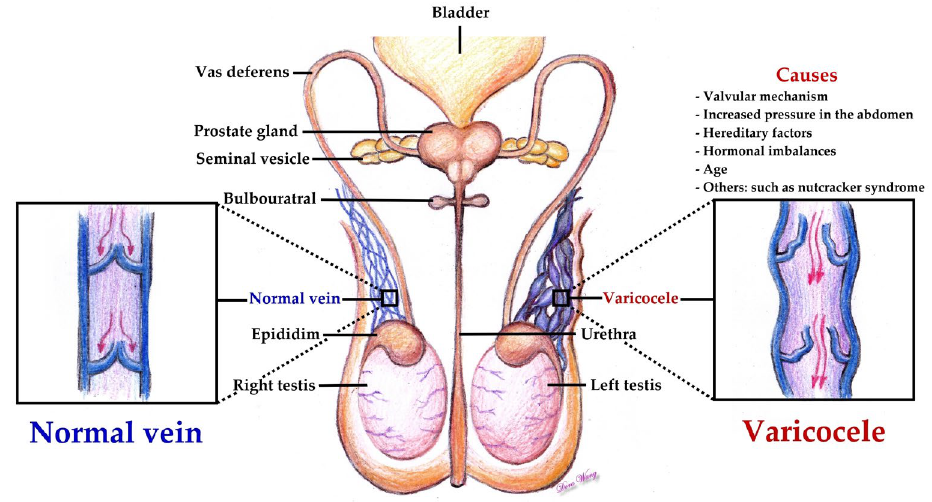
Figure 1. The scheme of pampiniform plexus; a loose network of small veins found within the male spermatic cord. The varicocele is a condition in which the veins in the scrotum, the loose pouch of skin that contains the testicles, become enlarged. These veins are responsible for carrying blood that has been depleted of oxygen away from the testicles. When blood begins to accumulate in the veins instead of flowing out of the scrotum, a varicocele